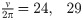
Numerical simulations of the STDP-driven synaptic dynamics of 1200 excitatory synapses in an isotropic “Ring Model” architecture, serving as feed-forward input onto a single conductance based post-synaptic neuron (see Methods for details).The pre-synaptic activity followed eq (17), with N = 1200, D = 10Sp/sec, A = 10Sp/sec and a varying angular frequency ν. Here we simulated the temporally anti-symmetric exponential STDP rule (eq (4) with τ± = 20ms), with α = 1, μ = 0, using a learning rate constant λ = 5·10−3. (A) The angular velocity V of the order parameter ψ (eq (34) in Revolutions per Hour—RPH) is plotted as a function of the oscillation frequency. (B, C and D) The synaptic weight profile as estimated numerically (calculated from the second half of the simulations, following convergence to the limit cycle), shown as a function of the pre-post phase difference, in red. Note the weight profile and the post phase drift at the same velocity, in red. The black curve shows the zero drift solution of eq (40). The vertical dashed gray line depicts the order parameter or “center of mass” ψ0 of the zero drift solution, the dashed blue line shows ψ0 + νd, and the pink line shows the “center of mass” ψ of the weight profile of the limit cycle solution. The panels differ in terms of the oscillation frequency of the pre-synaptic population ν2π=24, 29 and 36 Hz for panels B, C, and D, respectively.